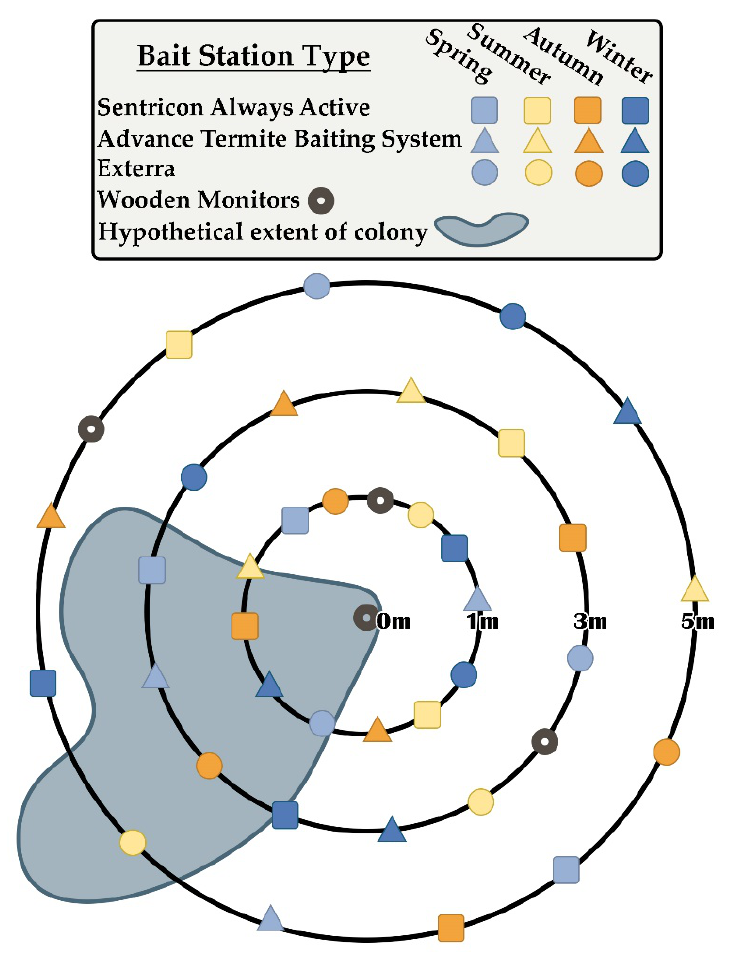
Figure 2. Representative example of study site arrays. Each site was centered on a specific location where subterranean termites had been observed and collected. Three bait station types were installed at three different distances from the site center during four different seasons during 2019 (see corresponding text for specific details and installation dates).